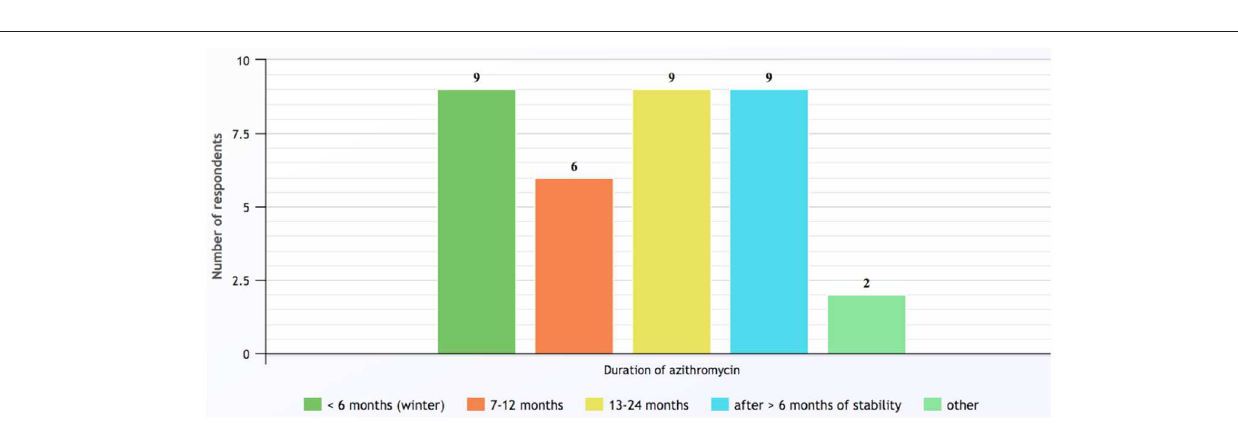
FIGURE 2 | Duration of long-term azithromycin courses prescribed by respondents for children with chronic suppurative lung disease and bronchiectasis. Note: category numbers are not mutually exclusive. Other responses included: Azithromycin prescribed only for cystic fibrosis patients; and duration determined by patient’s age and previous response following cessation of azithromycin (response to